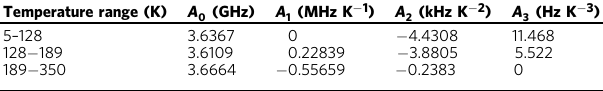
The three different temperature regions arise from the sectionally de fi ned polynomial for the temperature-dependent lattice parameters a and c 24 . The exact procedure of calculation can be found in the Supplementary